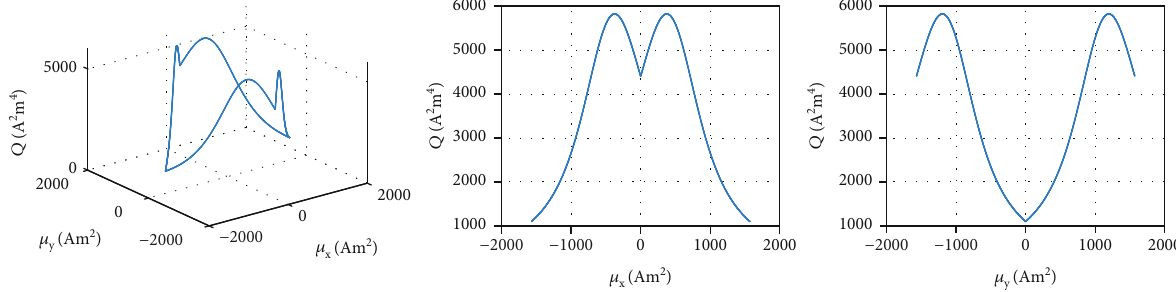
Figure 7: The desired force is [0.5 N, 0, 0] T .